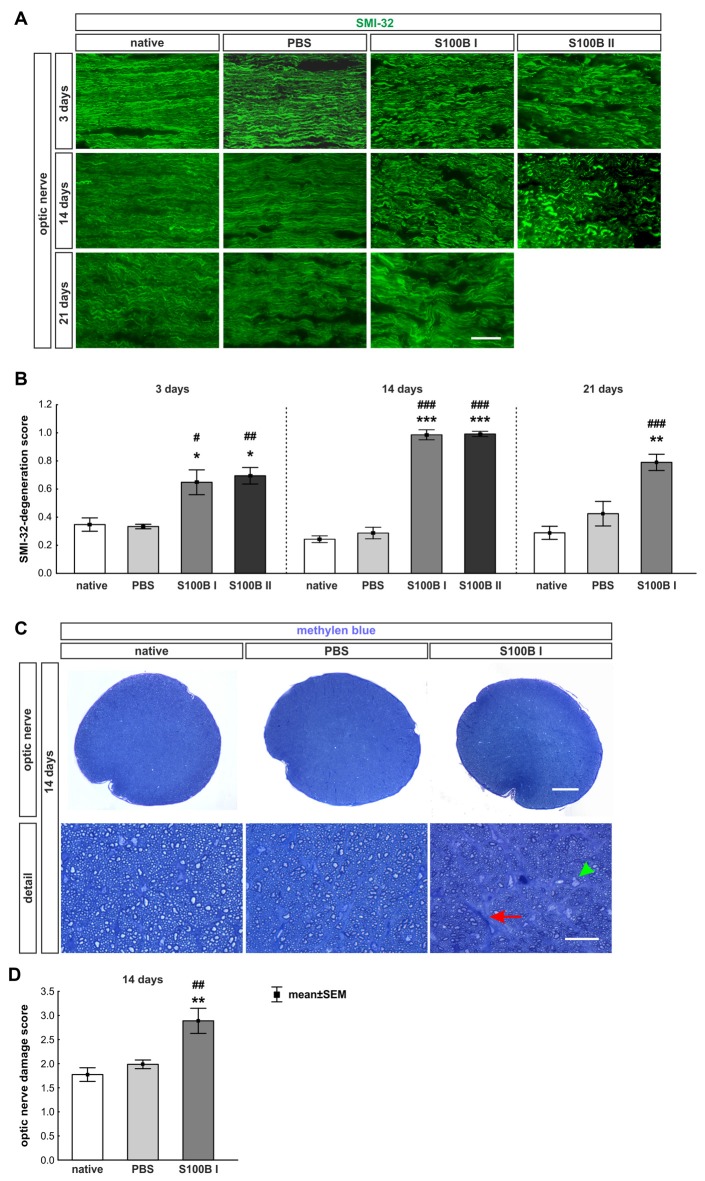
S100B induced progressive degeneration of optic nerve neurofilaments. (A) We analyzed neurofilaments of longitudinal optic nerve sections at 3, 14 and 21 days with anti-SMI-32-antibody (green). (B) At day 3, the neurofilament showed a low grade of degeneration in the S100B I (PBS: p = 0.02, native: p = 0.03) and S100B II group (PBS: p = 0.01, native: p = 0.005). These degeneration signs aggravated after 14 days compared to PBS and native group (both controls: S100B I: p < 0.001, S100B II: p < 0.001). After 21 days, destruction of neurofilaments was stable in S100B I group in comparison to PBS (p = 0.003) and native group (p < 0.001). (C) In addition, methylene blue stained cross-sections were scored at day 14. (D) The S100B I optic nerves showed more gliosis and an increased number of swollen axons compared to the PBS (p = 0.007) and native group (p = 0.001). Scale bar: (A) = 20 μm, (C) = 100 μm, (C) detail = 20 μm, red arrow: gliosis, green arrow head: swollen axon; *p < 0.05; **p < 0.01; ***p < 0.001 (compared to PBS group); #p < 0.05; ##p < 0.01; ###p < 0.001 (compared to native group).